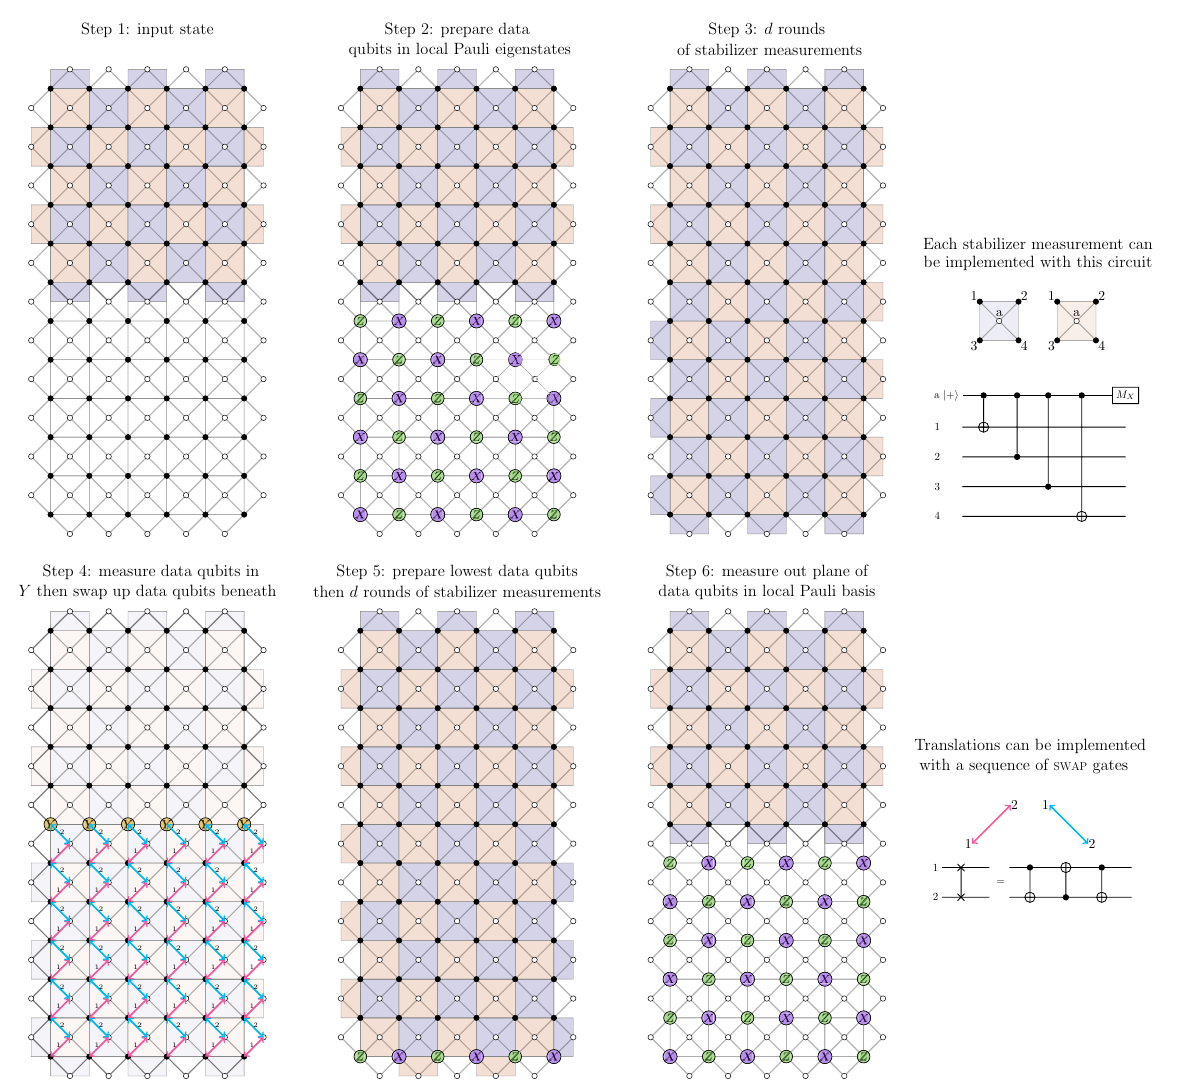
FIG. 23. Circuit-based instructions for the phase gate in Fig. 6, assuming that time slices are taken progressing from left to right. Data qubits are laid out in a square grid. We also depict the ancilla qubits required, which are placed on each face, and allow for the stabilizer measurements. Ancilla qubits are connected to neighboring data qubits, between which two qubit gates (such as CNOT gates) can be performed. At each step, the stabilizer measurements that are to be performed are highlighted—one may first measure stabilizers on plaquettes of one type before the other. In step 4, a row of data qubits is measured in the Pauli- Y basis, after which all data qubits below are translated up. This translation can be achieved with a two-step process using SWAP gates as shown. One may progress through the block in Fig. 6 in other directions, e.g., from front to back or bottom to top, leading to different instruction sets. For example, if we progress from front to back, then five-qubit twist operators need to be